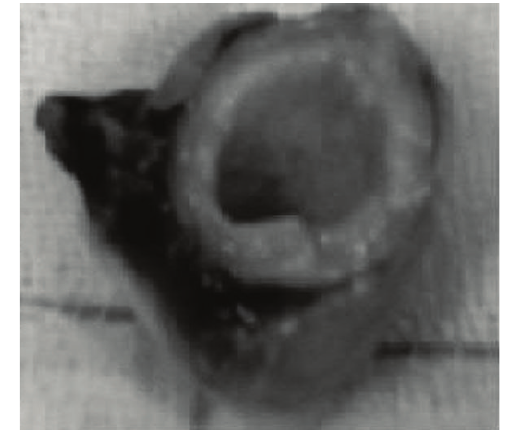
Figure 2: Intraoperative ascending aorta specimen.